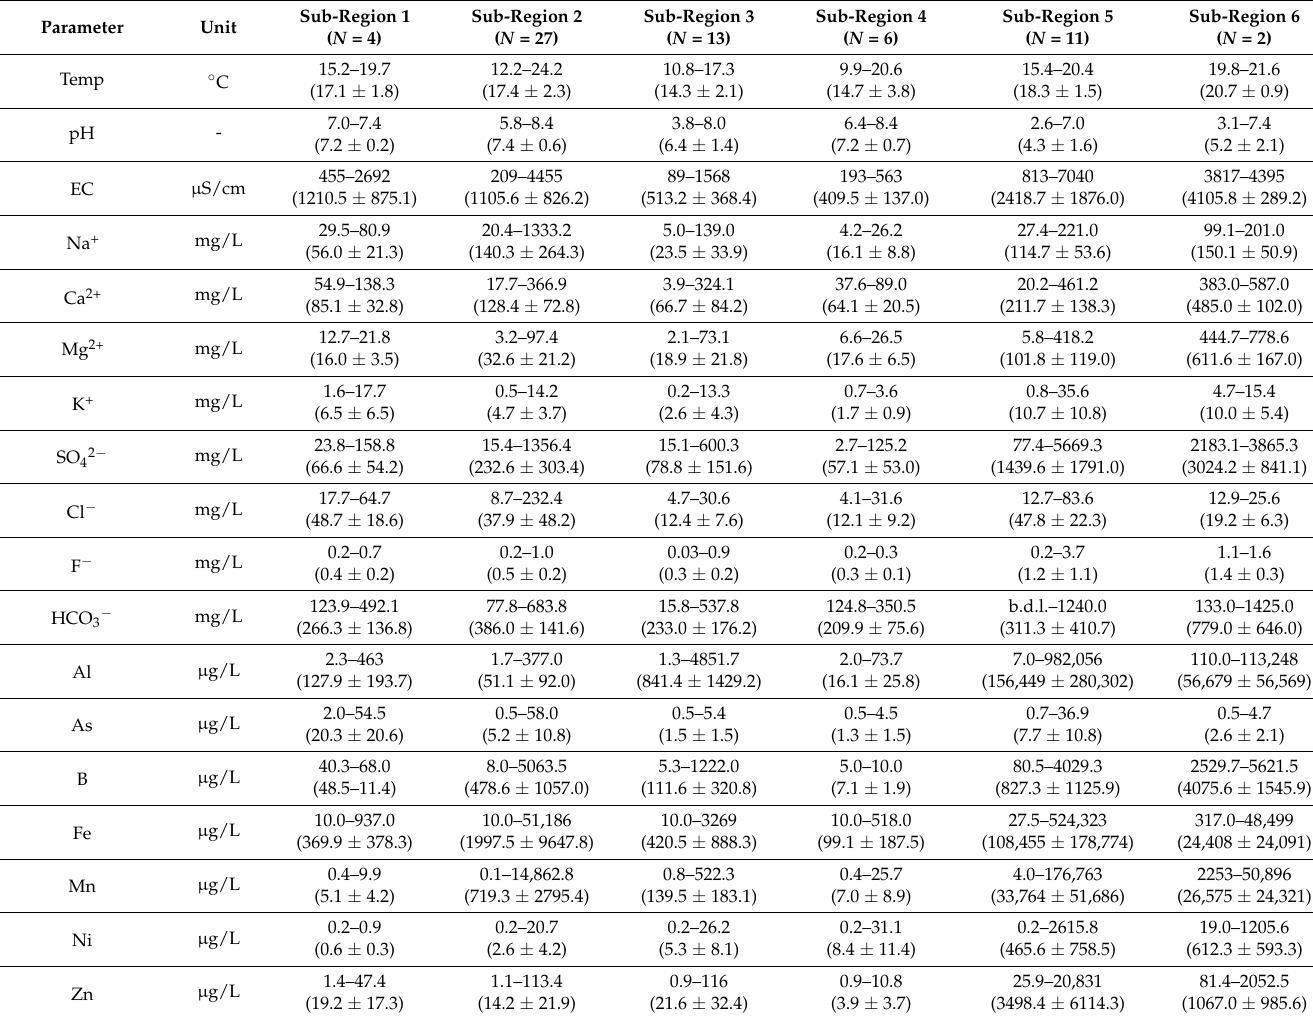
Table 2. Summary of statistics (min. max. and avg. ± std. dev.) of water quality with respect to